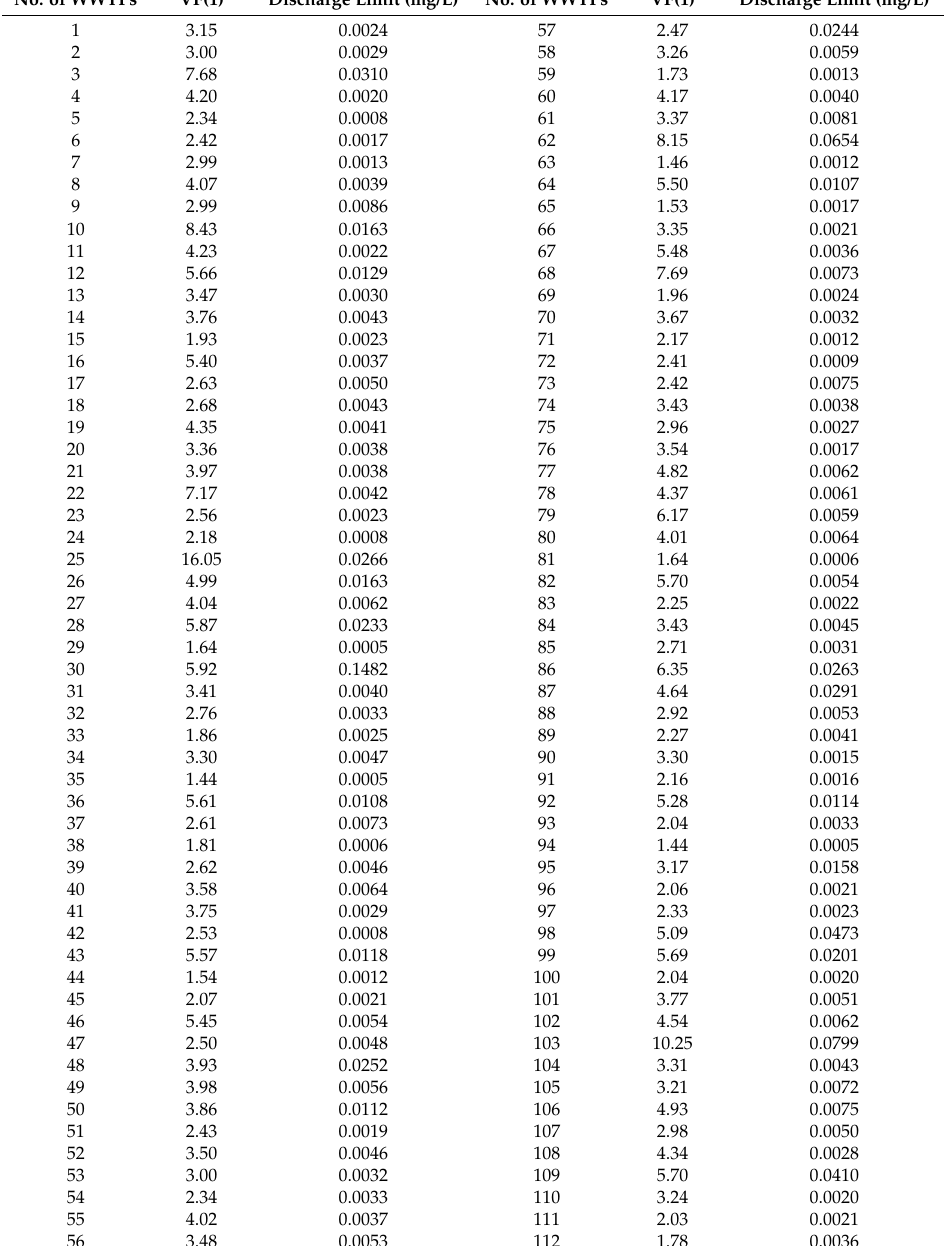
Table 10. VF(1)s and derived discharge limits of As for 112